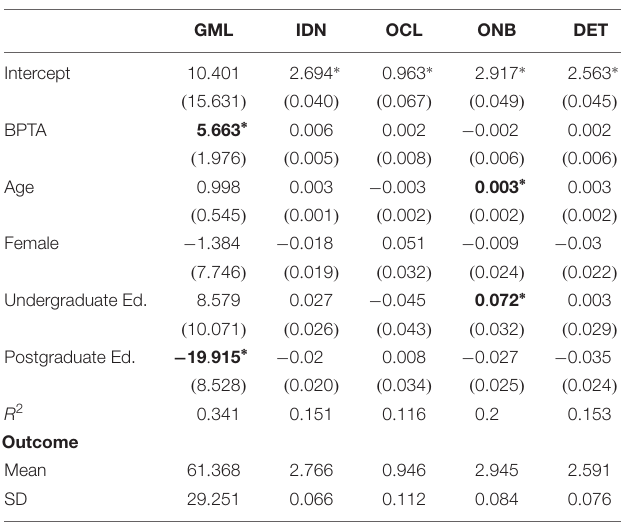
TABLE 3 | Regressions for baseline cognitive